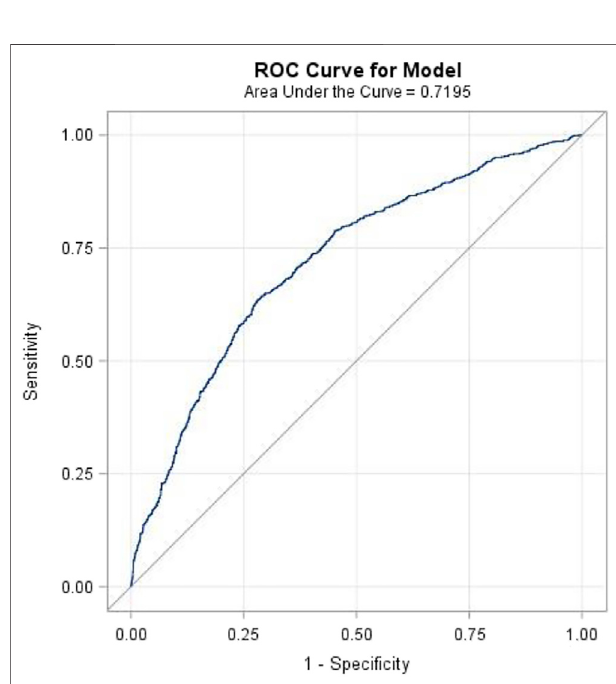
FIGURE 2 | The area under the curve (AUC) for bronchiectasis-asthma cohort applied to predict pulmonary tuberculosis or pneumonia.